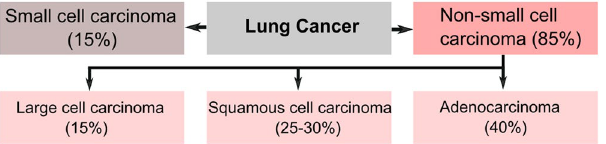
Figure 1. Incidence of the histological subtypes of lung cancer. Lung cancer is subdivided into various histological subtypes. The main distinction is between small cell lung cancer (15%) and non-small cell lung cancer (85%). Non-small cell lung cancer further subdivides into three major histological subtypes, namely adenocarcinoma (40%), squamous cell carcinoma (25–30%), and large cell carcinoma (15%).